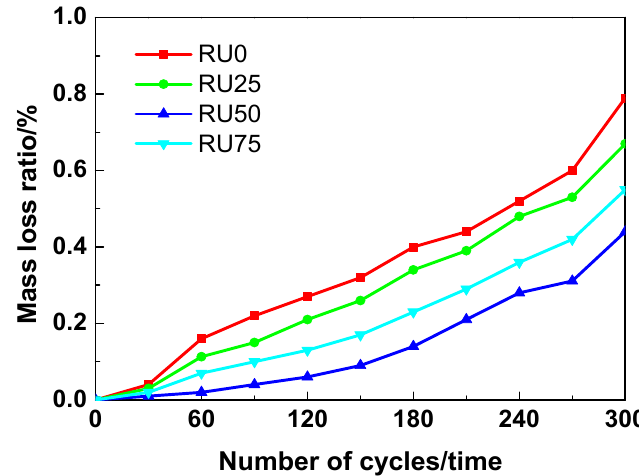
Figure 10. The mass loss ratio of RS-UHPC with different contents of GO.